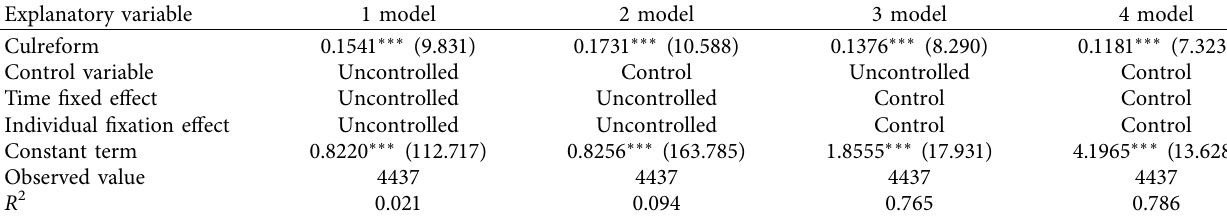
Table 3: Benchmark regression